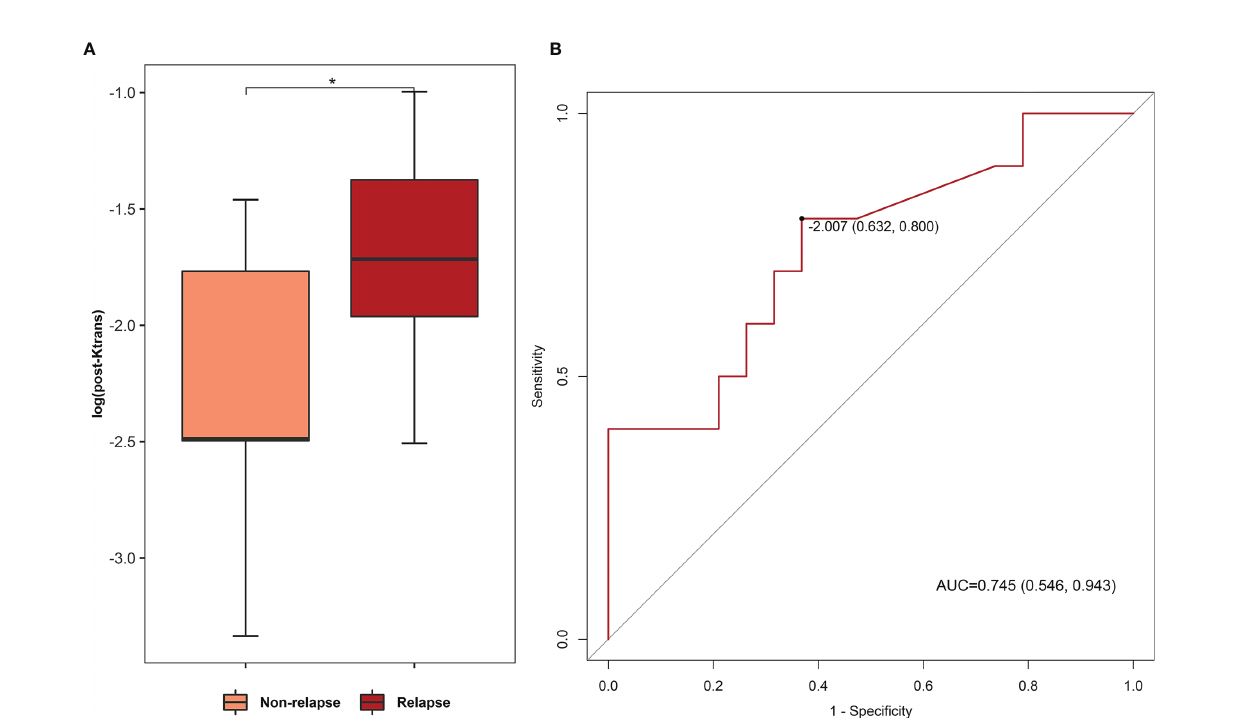
FIGURE 5 | (A) Comparison of post-bevacizumab K trans levels between non-relapse and relapse groups. (B) ROC analysis of post-bevacizumab K trans level for relapse prediction. (AUC 0.745, P < 0.05, 95% CI 0.546 – 0.943, sensitivity = 0.800, speci fi city = 0.631; cutoff value based on Youden index: log 10 K trans = − 2.01). *P value <